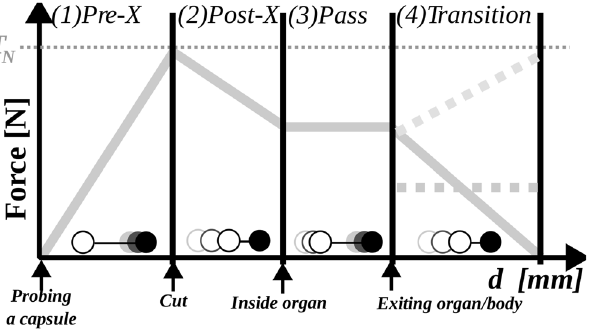
Figure 14. Concept of our four phases: The proxy-tip relation is indicated by circles above the x-axis (empty circles = proxy, filled circles = tip; time = gray-scale).